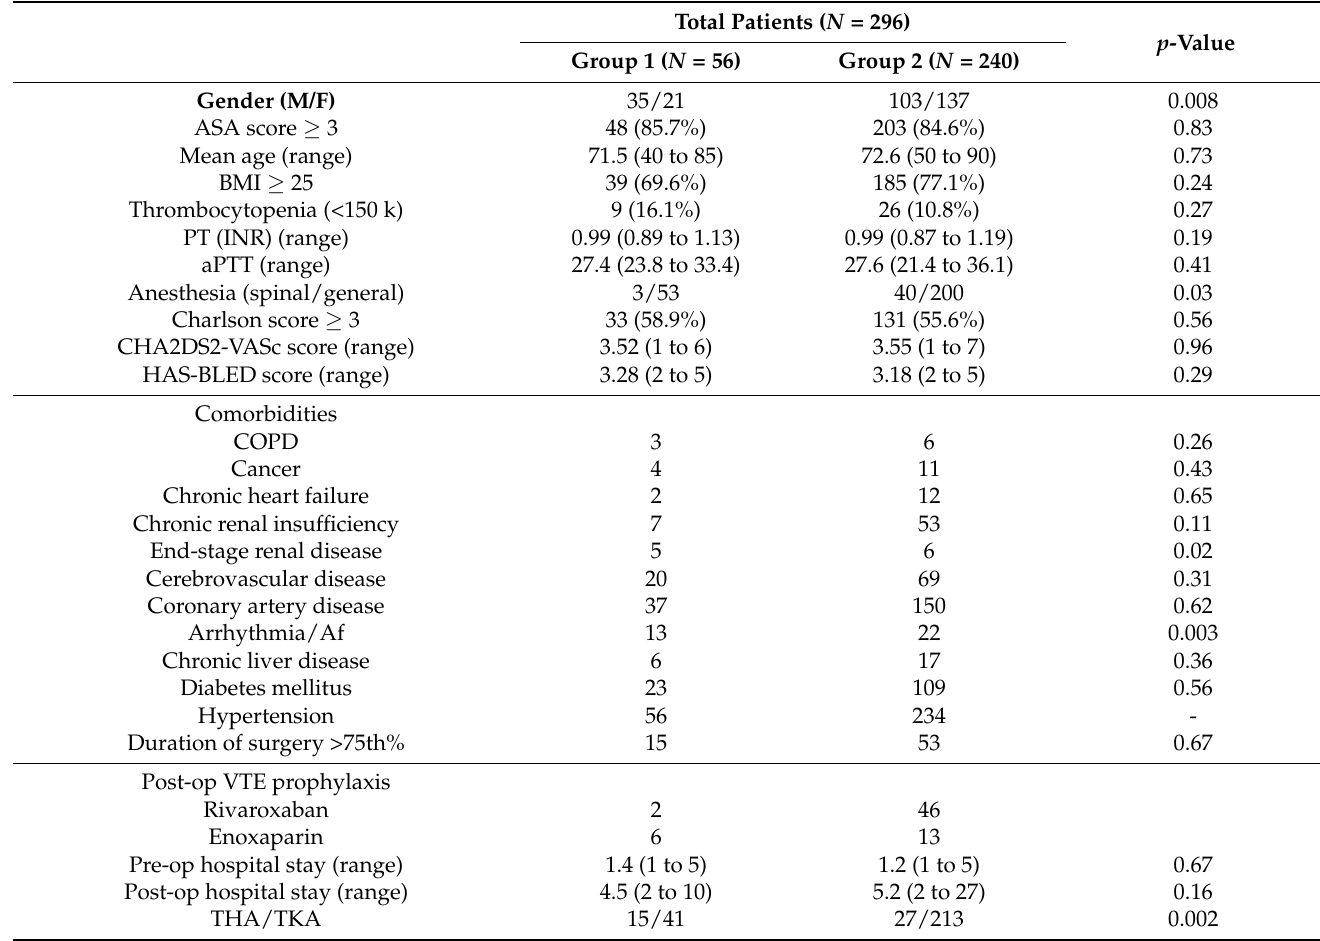
Figure 1. Main indications of clopidogrel in the study patients. Table 1. Demographic data of the study patients.